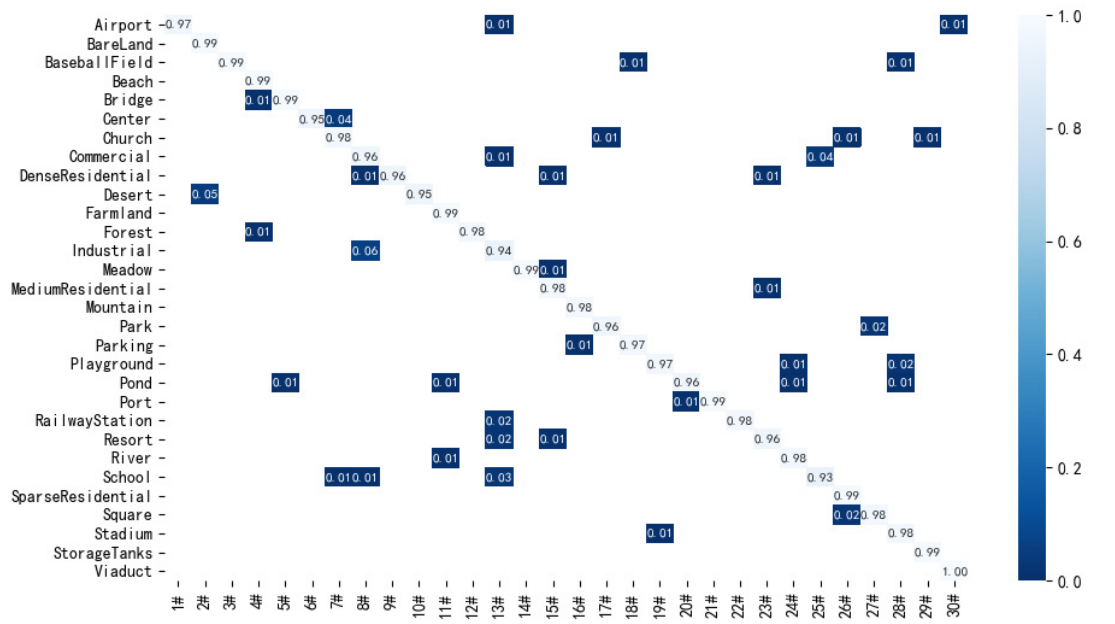
Figure 12. Confusion matrix of the proposed method on the AID dataset with 50% training ratio.